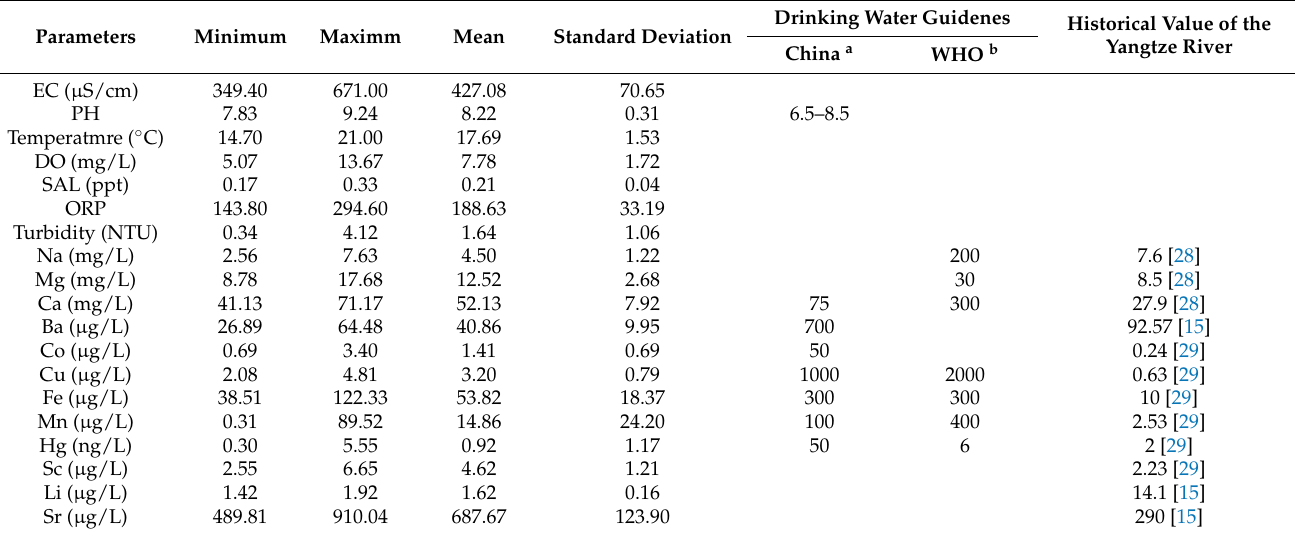
Table 3. Statistical of the physical and chemical parameters of the river